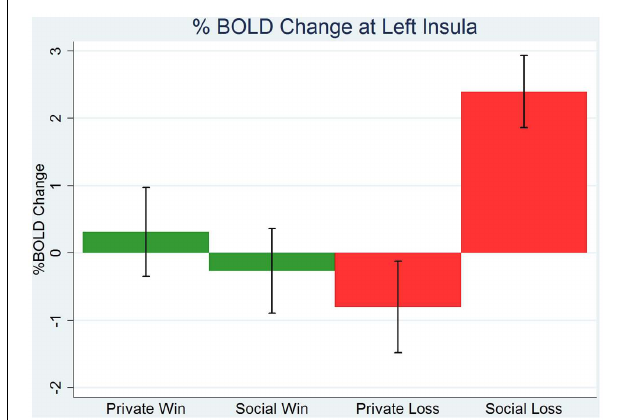
FIGURE 5 | Region-of-interest analysis of left anterior insula shows increased activity only to social loss (equal to 1 if advantage is strictly less than 0 in social environment, and equal to 0 otherwise), and around zero or slightly negative activity in cases of social win or private